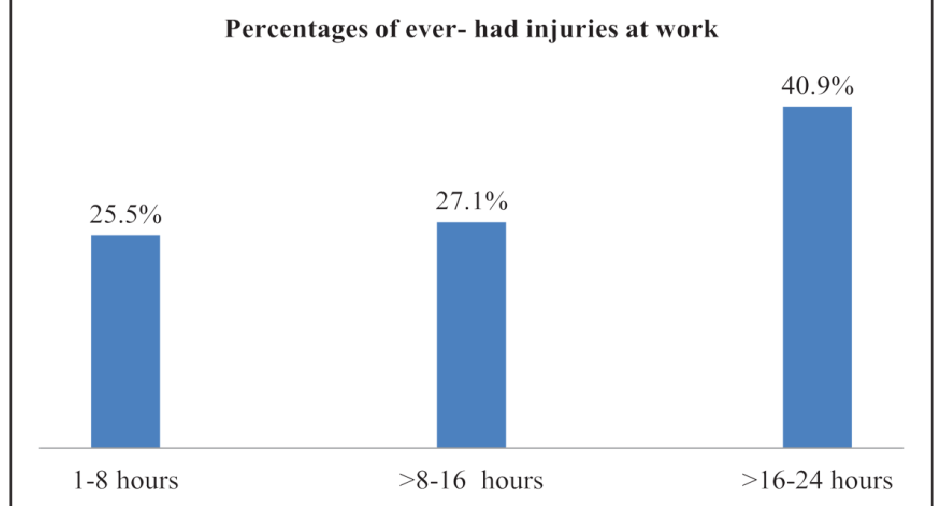
Figure 2. Injuries and daily working hours: Percentages of ever-had injuries at work according to daily working hours reported by miners in Kadoma and Shurugwi, Zimbabwe, in 2020. Total re- sponses: 1 – 8 h = 243, >8 – 16 h = 70, and >16 – 24 h = 44.